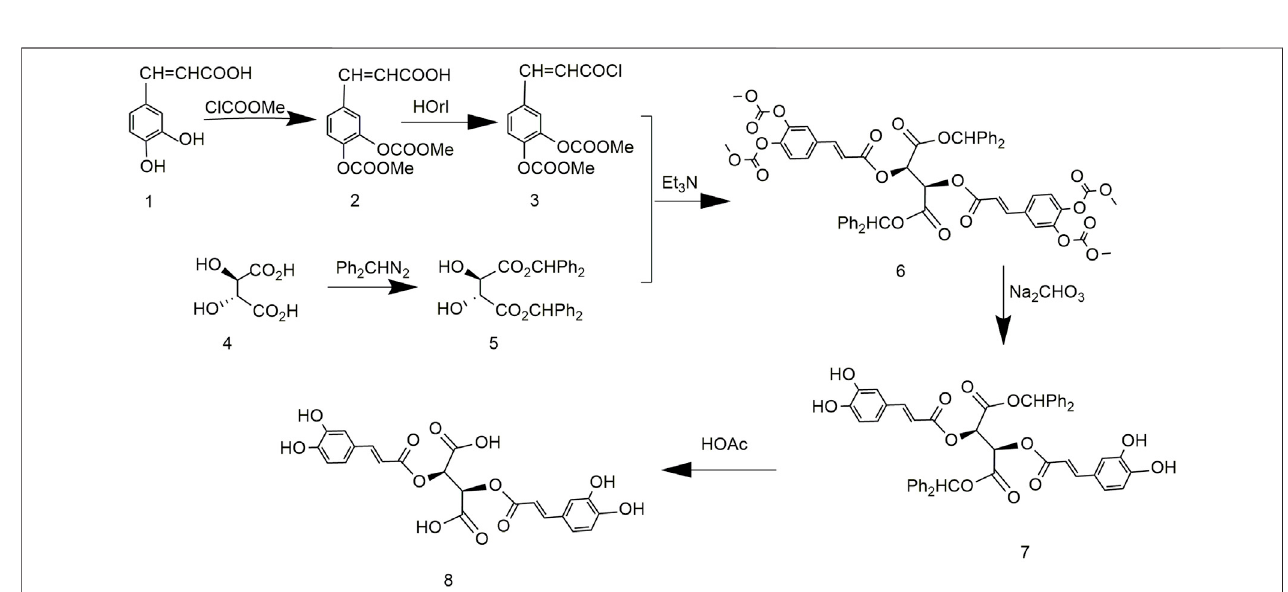
FIGURE 5 | Chemical synthesis pathway 3 of chicoric